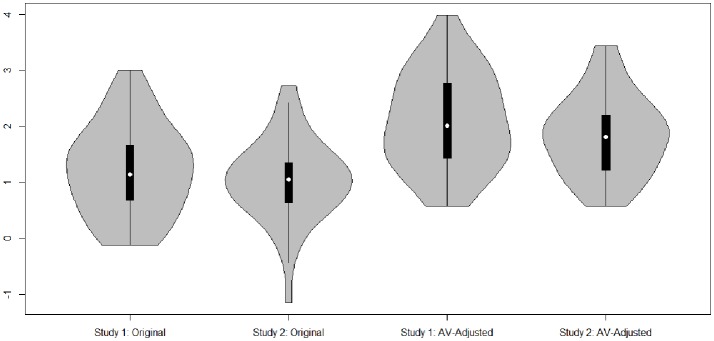
Violin plots of discrimination parameters of the original self-report questions and the AV-adjusted answers for Rwanda and Philippines.